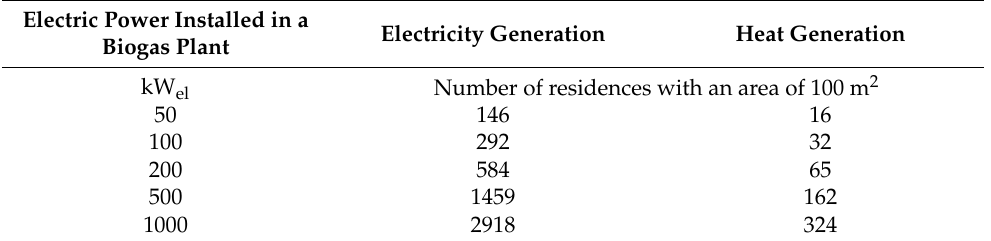
Table 9. The number of residences with an area of 100 m 2 supplied with electricity and heat depending on the size of the biogas plant.